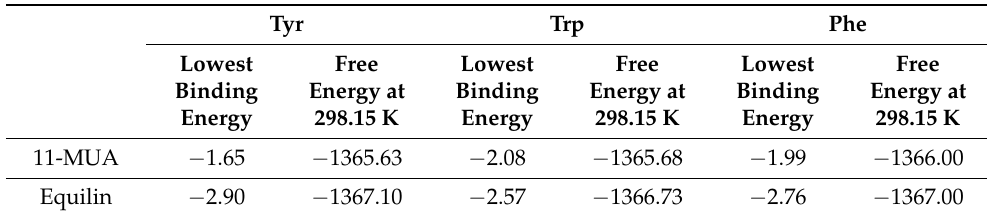
Table 1. The theoretical lowest binding energy (kcal/mol) and free energy (kcal/mol) results of 11-MUA and Equ with respect to Tyr, Trp and